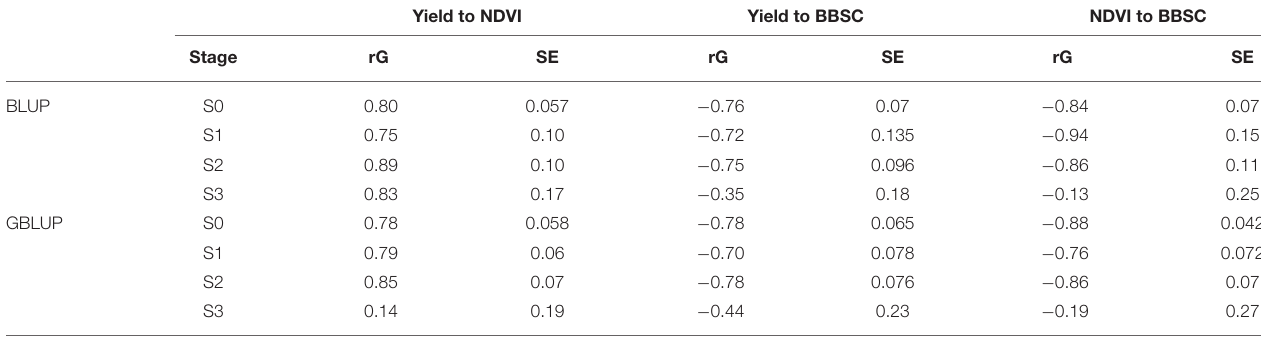
TABLE 2 | The genetic correlation and the standard error (SE) between traits estimated with BLUP and GBLUP models within each breeding stage.